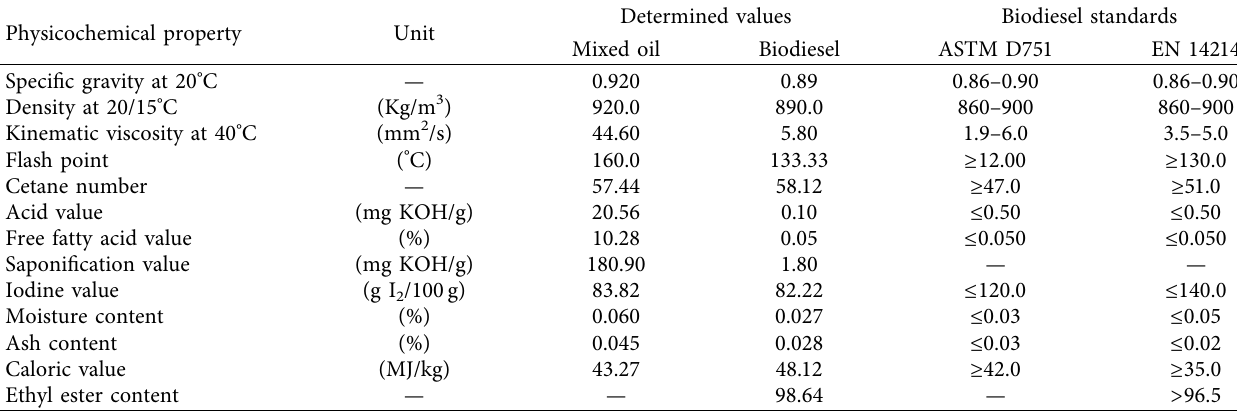
Table 1: Properties of mixed oil and biodiesel produced under optimum conditions from the mixed oil. Physicochemical